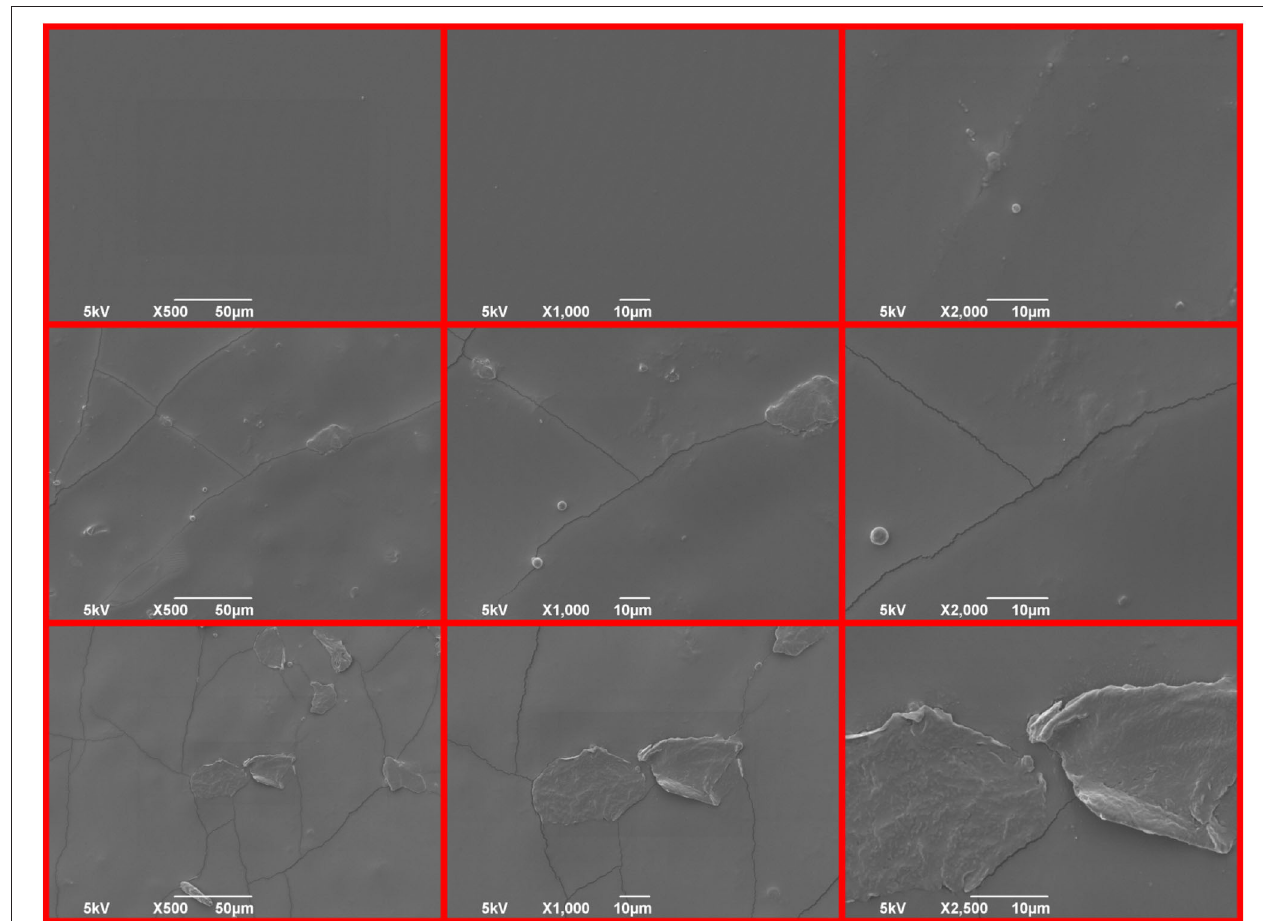
FIGURE 3 | Top row of images shows the flat surface of pure E43. The middle row shows the presence of some flaking and cracks on the flat surface of sample E43PS50. The bottom row presents the flat surface (that has been immersed in water) of sample E43PS50W with bigger and frequent